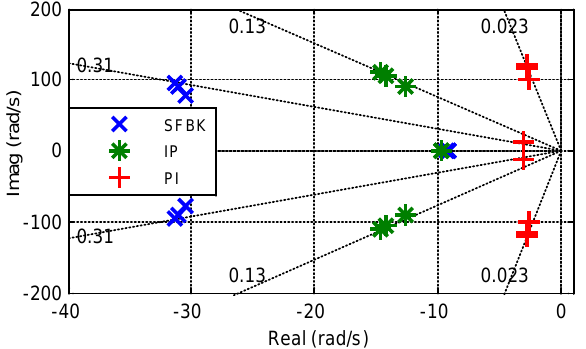
Figure 11. Loci of dominant poles with load torque variation for PI, IP and SFBK